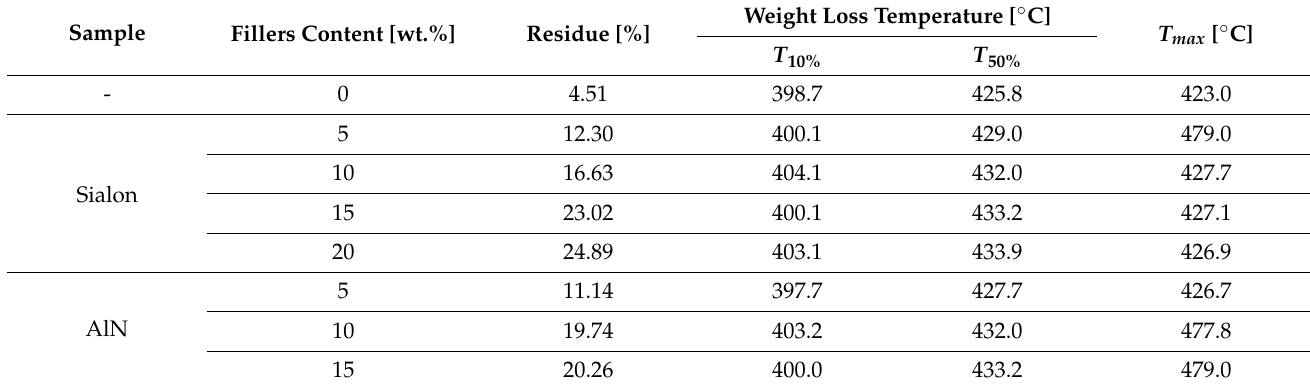
Figure 5. TGA and DTG curves for coatings containing: ( a ) Sialon, ( b ) AlN. Table 1. Results of the thermal decomposition of